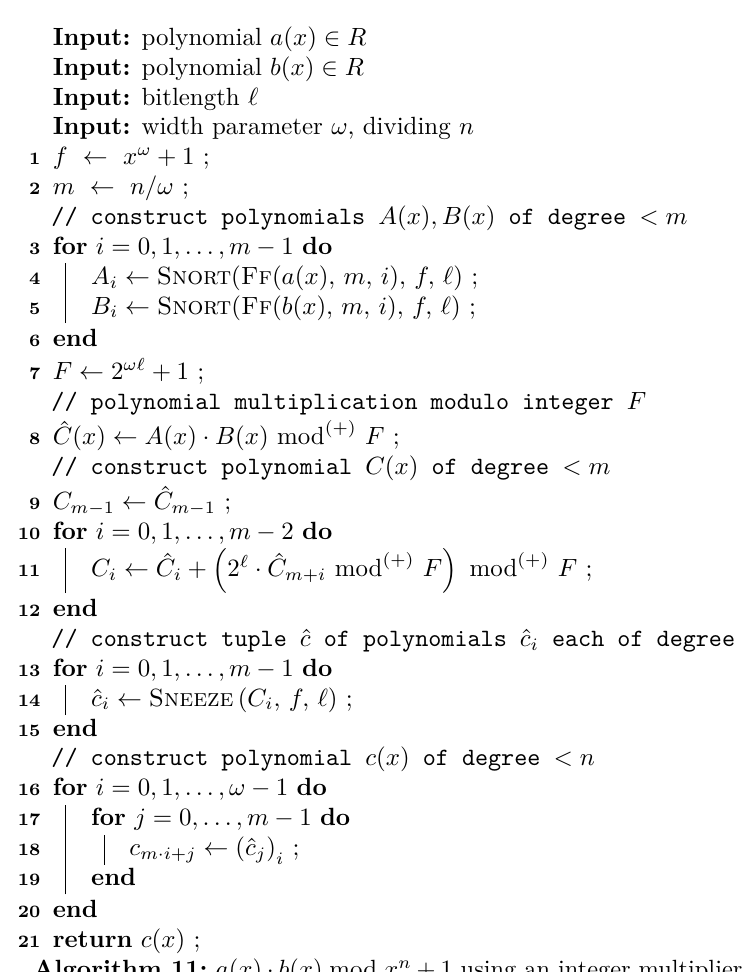
Algorithm 11: a ( x ) · b ( x ) mod x n + 1 using an integer multiplier capable of performing modular multiplication of integers up to ω‘ + 1